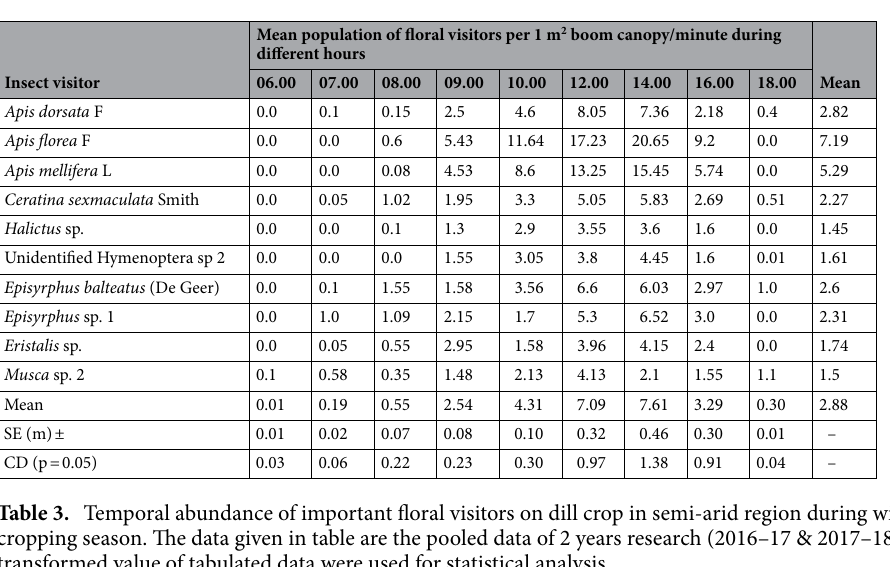
Pollination effectiveness. The effect of different modes of pollination on seed yield and quality attributes of A. graveolens was studied under statistically well designed field experimentation and data presented in Table 4, revealed that, the insect pollinators significantly affected the seed yield (P ≤ 0.05, Duncan’s Multiple Range test DMRT). The effect of different modes of pollination on yield was evident as the lowest seed yield of 958.7 kg/ha was recorded in the plots considered as control (WIP) having no input of floral visitors, and significantly inferior to all adopted modes of pollination. The highest seed yield of 1505.63 kg/ha was recorded in open pollination